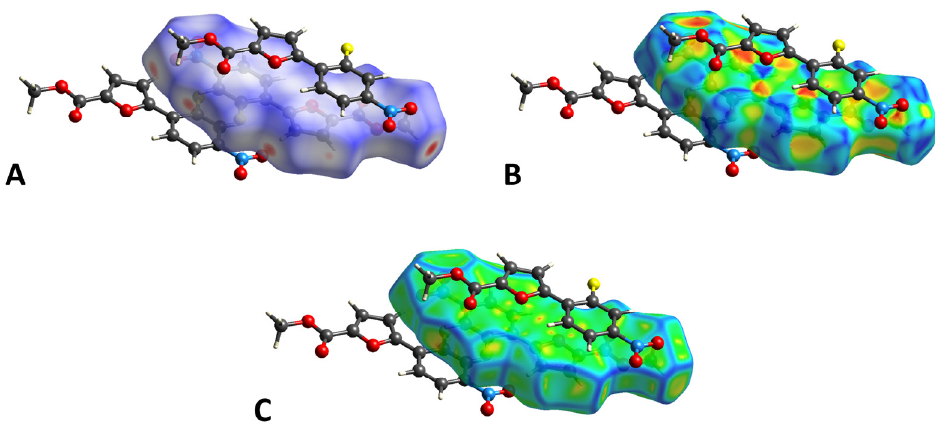
Figure 3. ( A ) HS mapped over d norm with a fixed color scale in the range of − 0.1942 au (red)–1.1392 au (blue), based on the length of the intermolecular contacts with respect to the sum of the van der Waals radii (red: shorter; blue: longer; white: same). ( B ) HS mapped over the shape index (color scale: − 0.9896 au–0.9973 au). Blue areas represent bumps, and red regions indicate hollows. ( C ) HS mapped over the curvedness (color scale: − 3.3180 au–0.2180 au). Flat regions are in green, while edges are in blue.